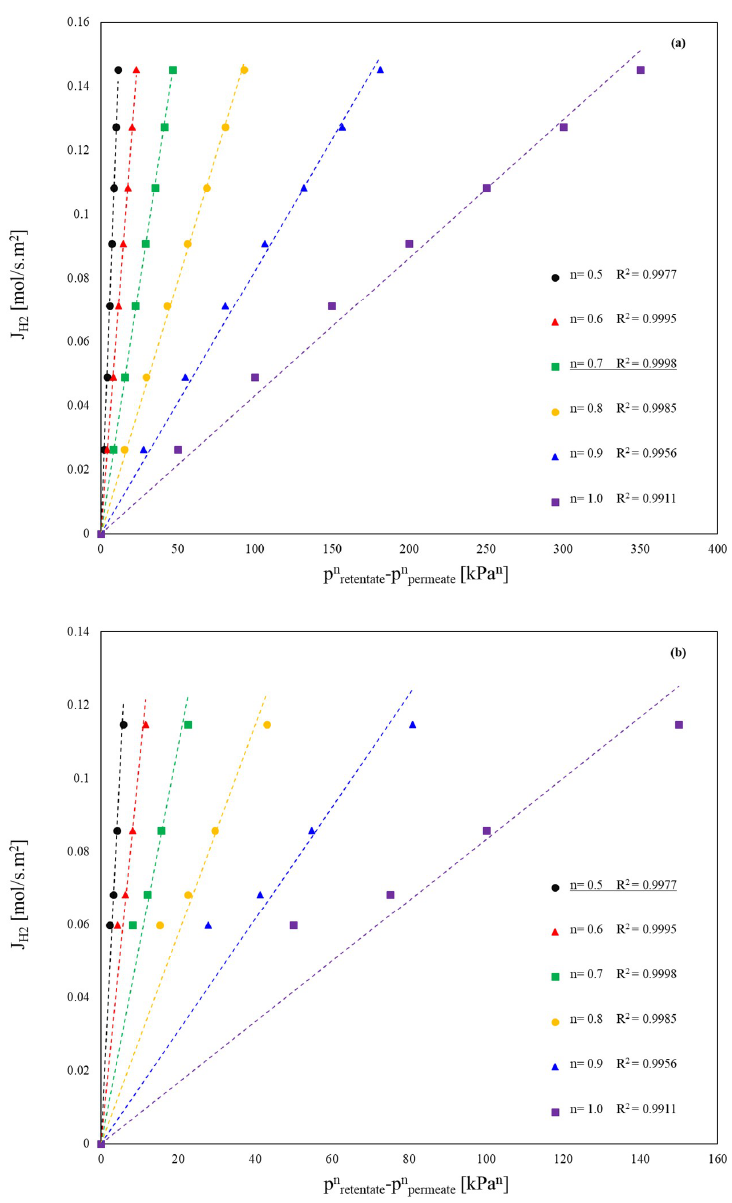
Figure 2. Permeating flux of H 2 vs. trans-membrane pressure at 400 °C and various values of n for ( a ) Pd membrane ( b ) Pd-Au membrane.